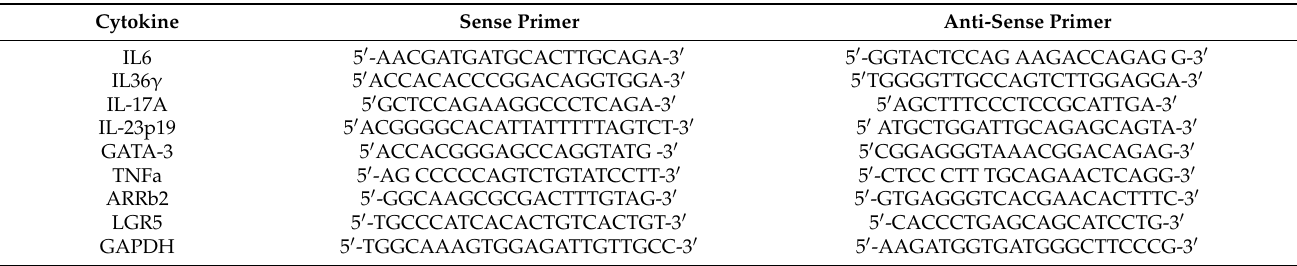
Table 1. Primers used for cytokine